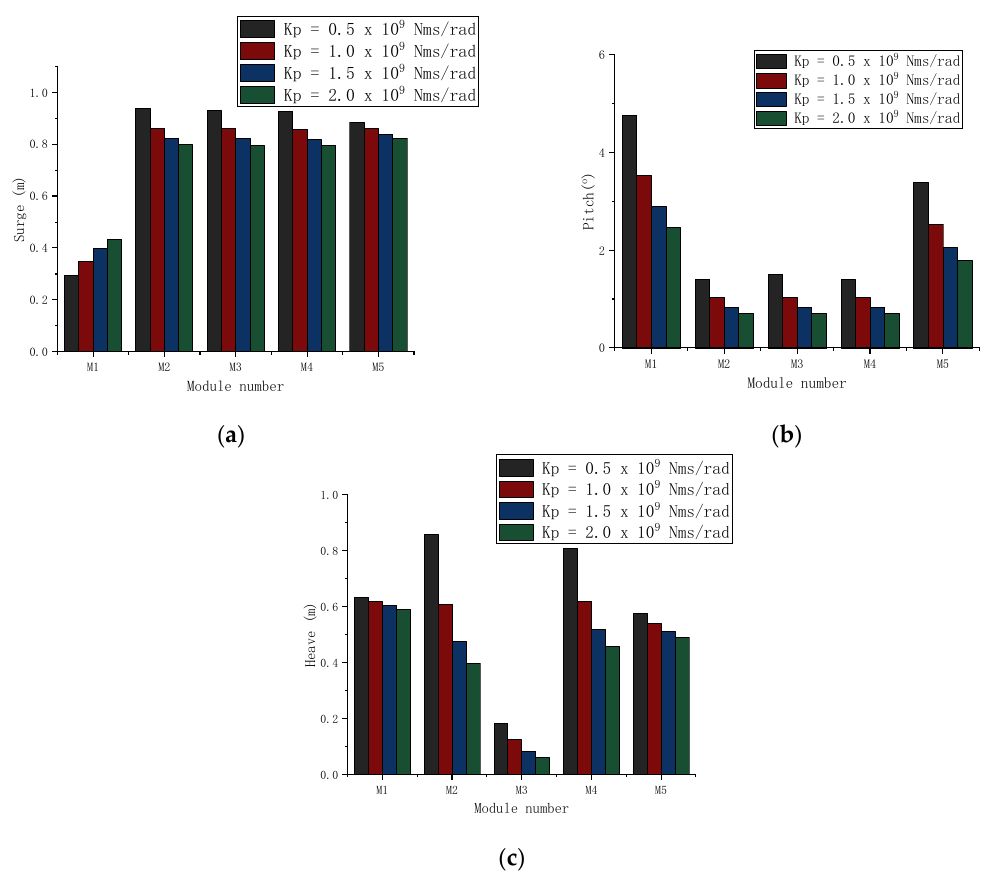
Figure 4. Dynamic responses of each module with different K p : ( a ) surge; ( b ) heave; and ( c ) pitch. Table 2. Mean output power and main C1 loads with different K p